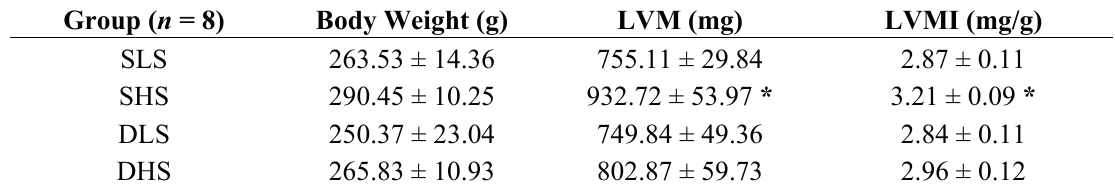
Table 1. LVM and LVMI of the four groups after